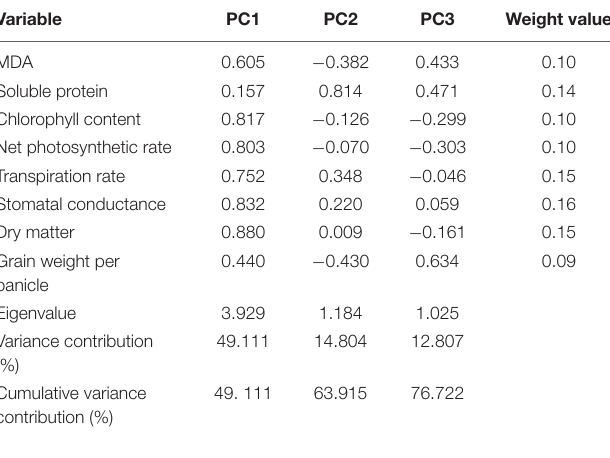
TABLE 3 | First three principal components (PCs) of variable project, eigenvalues, variability (%), cumulative (%), and weight value.